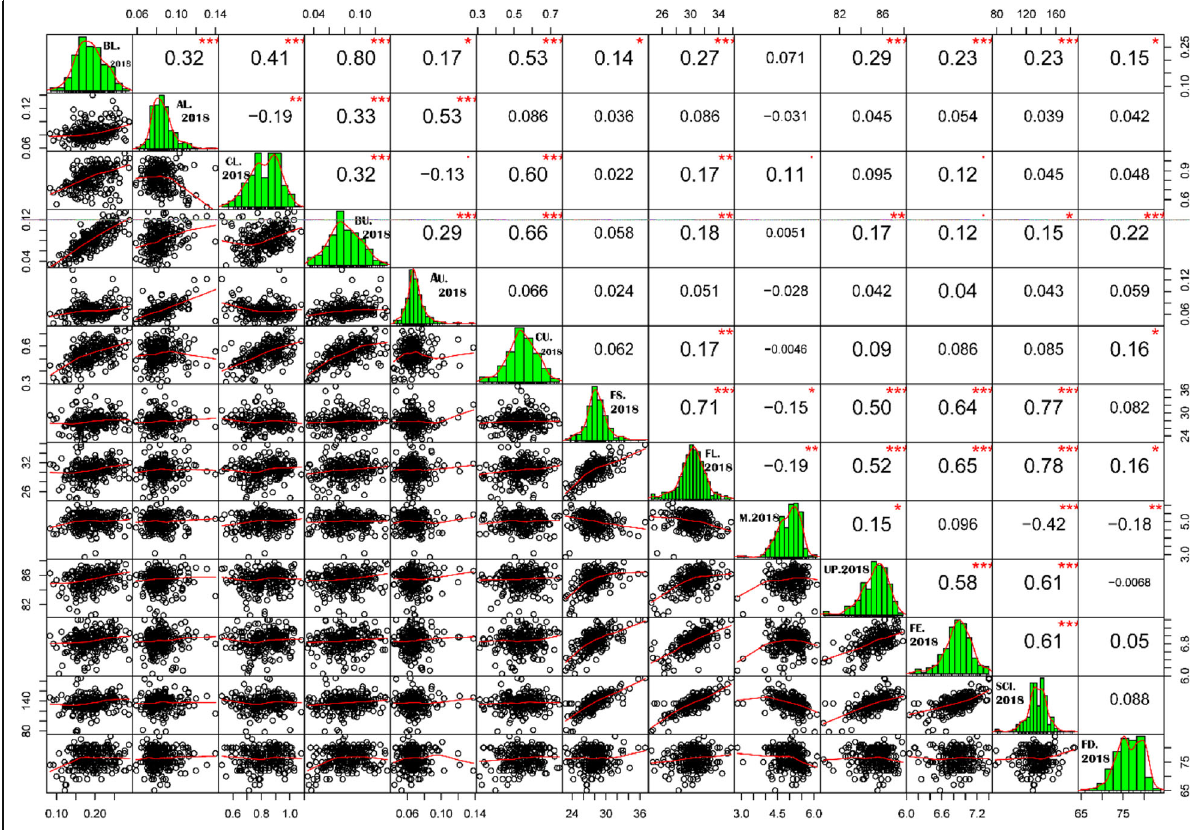
Fig. 1 Frequency distribution of phenotypic variation of six stem hardness related traits and seven fiber-related traits and correlation coefficients among the traits in 237 accessions. BL: bending lower; AL: acupuncture lower; CL: compression lower; BU: bending upper; AU: acupuncture upper; CU: compression upper; FS: fiber strength; FL: fiber length; MI: micronaire index; E: elongation ratio; UP: uniformity percentage: FE: fiber elongation; SCI: spinning consistency index; FD: days to flowering. *, **, ***: significant at P = 0.05, P =0.01, P =0.001, respectively